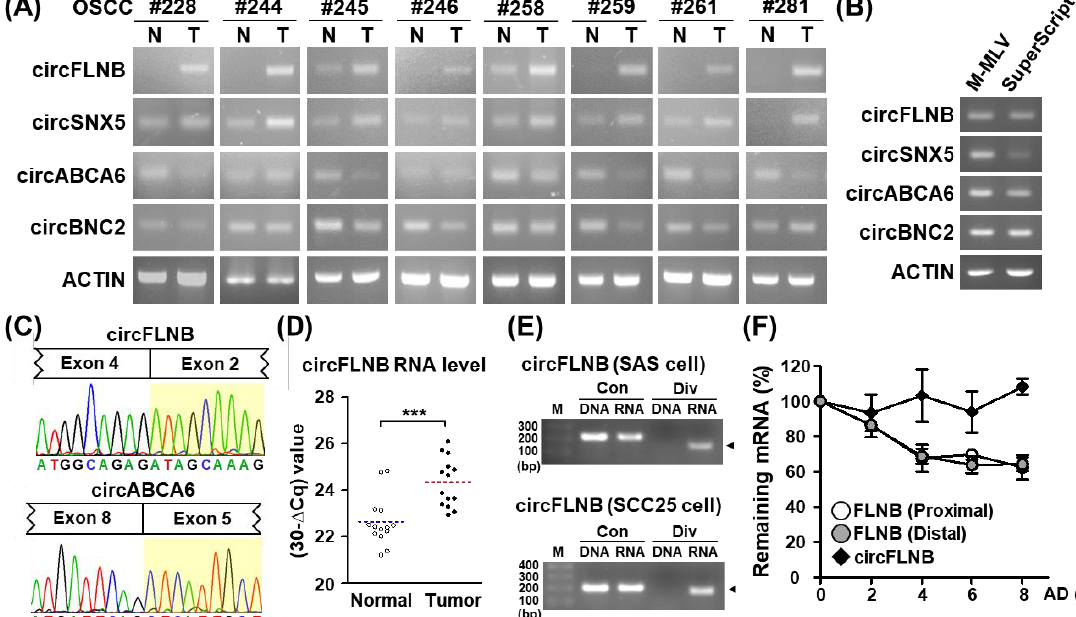
Figure 3. Validation and characterization of di ff erentially expressed circRNAs in OSCC. ( A ) Expression of selected circRNAs in paired OSCC specimens was detected by end-point PCR. ACTIN gene expression was used as the loading control. ( B ) End-point PCR analyses of complementary DNA (cDNA) generated by M-MLV or SuperScript reverse transcriptases were performed to exclude the detection of artificial circRNA. ACTIN was used as the internal control. ( C ) Two exemplary circRNAs were PCR-amplified, and then subjected to Sanger sequencing. Histograms illustrate the junctional sequences flanking the back-splicing sites (with exons indicated above). ( D ) Upregulated circFLNB expression in tumor samples vs. adjacent normal tissues was confirmed by qRT-PCR analysis of an independent patient cohort. TBP gene expression was used as an internal control. For statistical analyses shown in this figure: *** p < 0.001. ( E ) PCR of genomic DNA (DNA) and reverse-transcribed cDNA (RNA) was performed with primers in the convergent (Con) and divergent (Div) orientations and analyzed by gel electrophoresis. ( F ) To monitor transcript stability, SAS cells were treated with actinomycin D (AD) for the indicated time lengths, then harvested for qRT-PCR-based gene expression analysis. RNA turnover rate was measured by normalization of RNA abundance relative to the initial time point and plotted for each indicated gene.